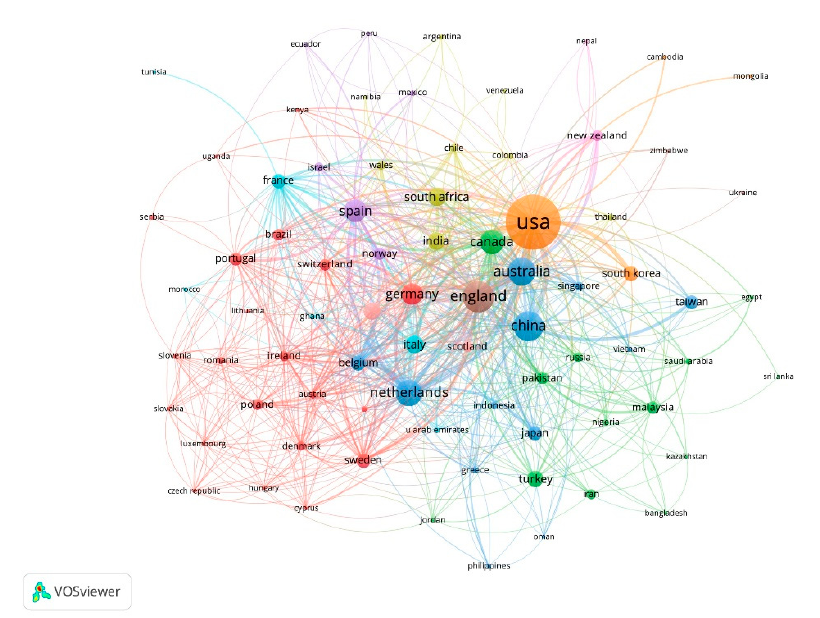
Figure 5. Network country cooperation based on co-authorship.